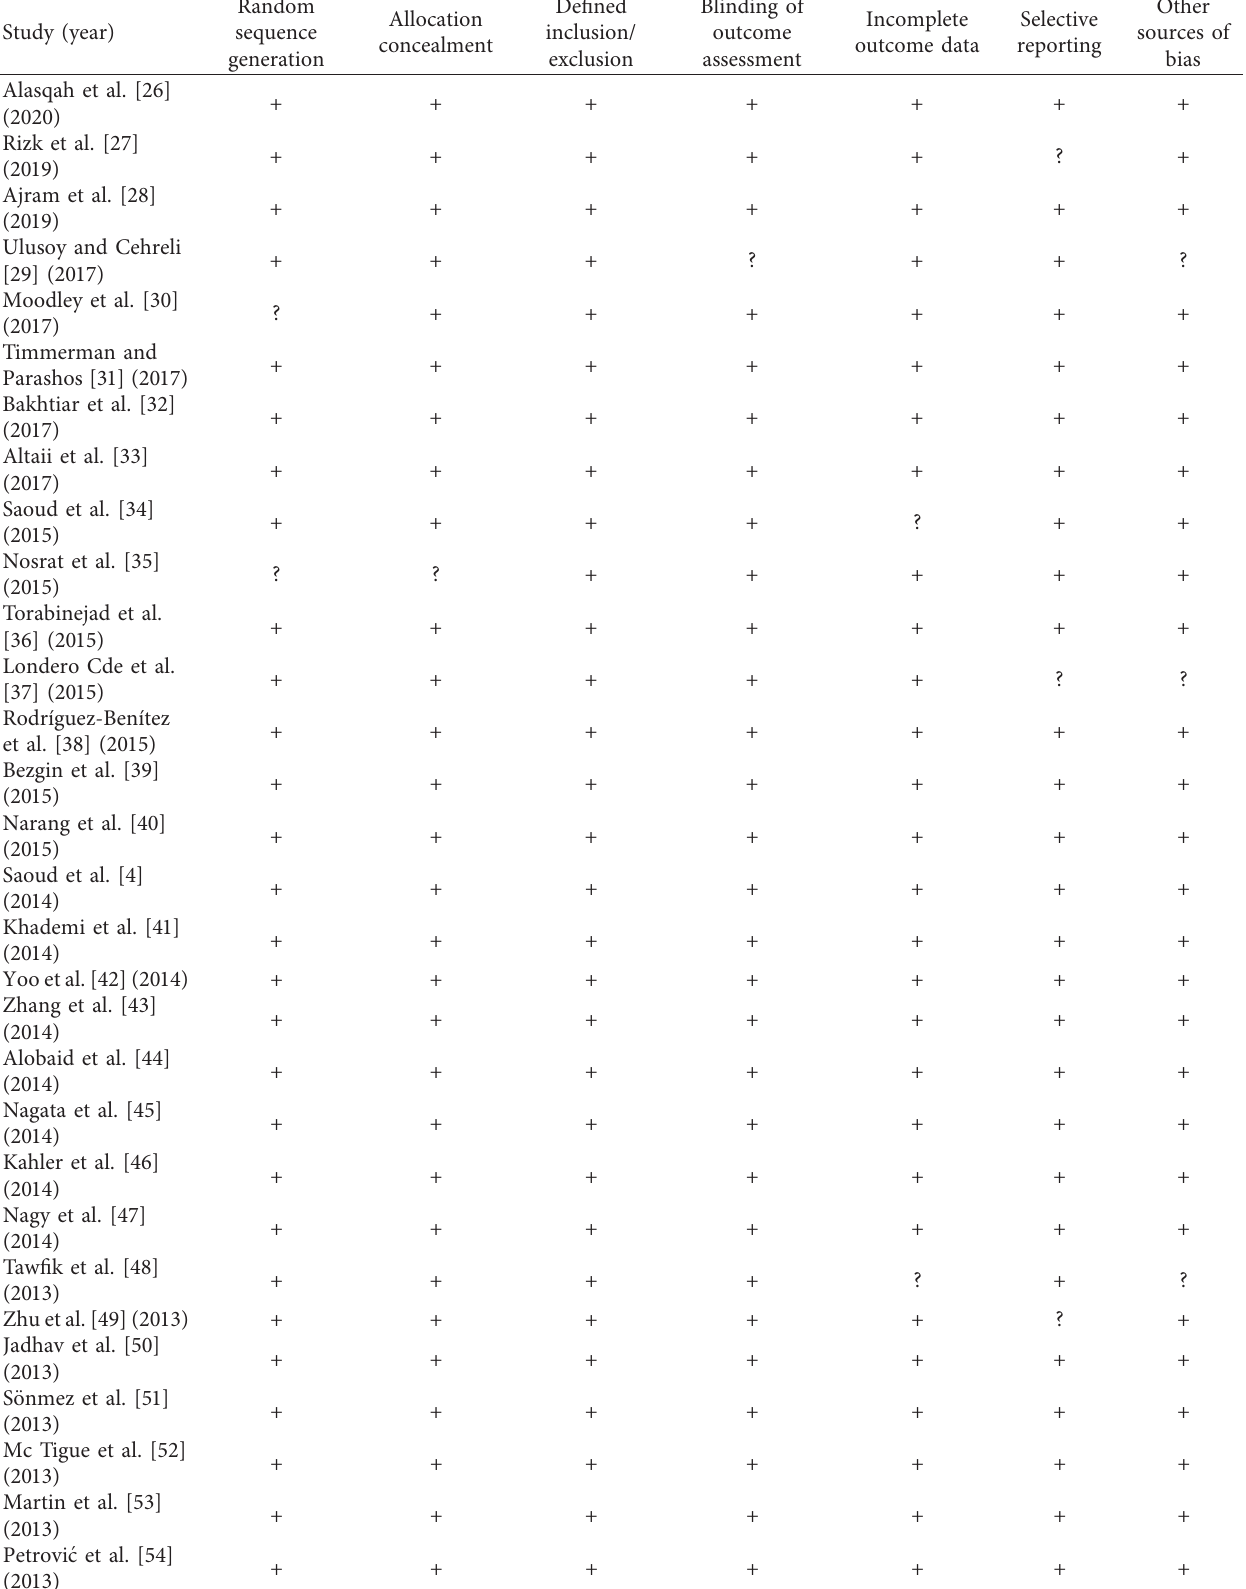
Table 3: Quality and risk Assessment of all the included studies in this systematic